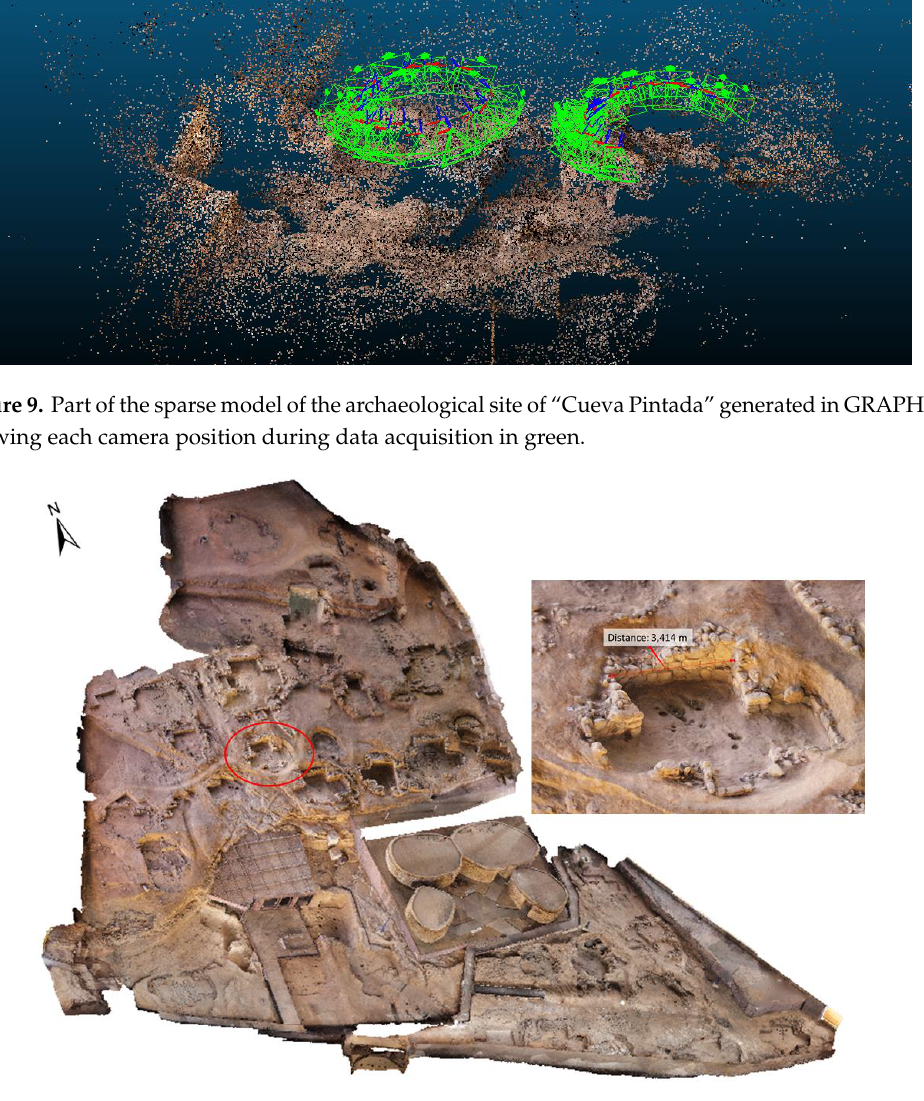
Figure 10. Photorealistic 3D model of the “Cueva Pintada” archaeological site and the remains of a house in detail.